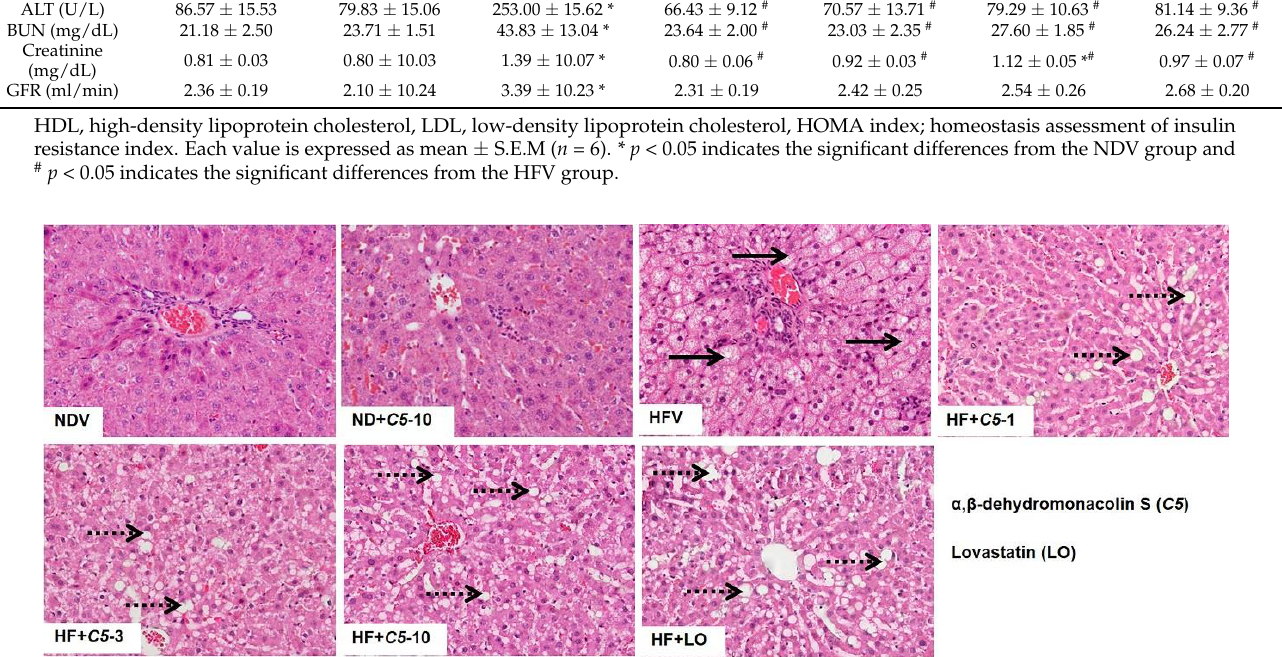
Figure 2. Micrographs of rat liver morphology. Liver tissues from each animal was removed, fixed, embedded, cut, stained by hematoxylin and eosin (H&E). The data were analyzed using bright-field microscopy with original magnification 100× and performed at least 3 times from separate sets of animals. Black arrow indicates microvesicular steatosis and black dot arrow indicates macrovesicular steatosis.